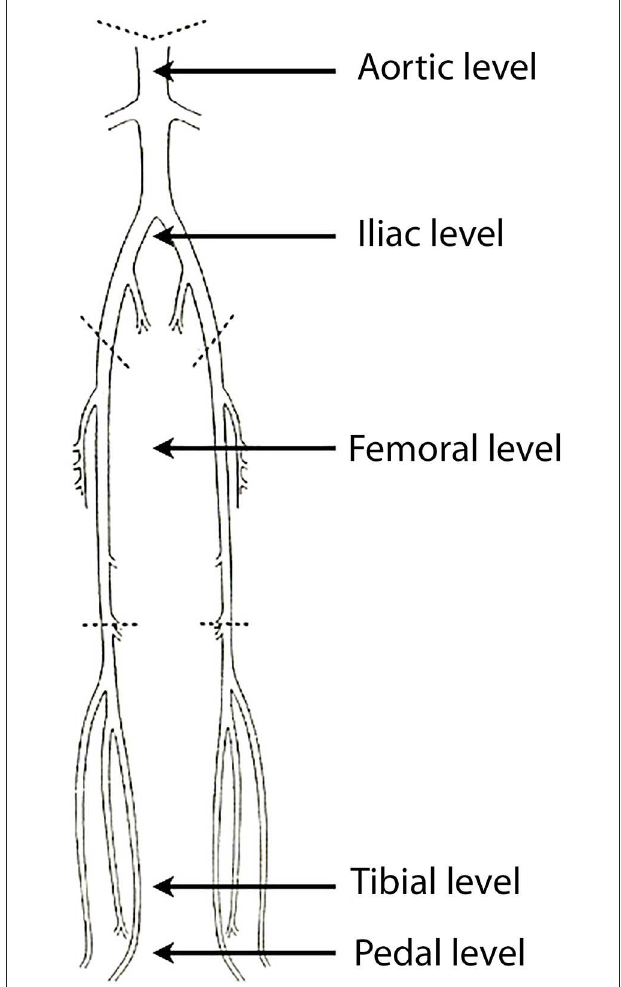
FIGURE 1 | Graphical representation of the arterial supply of the lower limbs. Intraluminal CT values were measured at five levels of interest (black arrows): aortic level, iliac level, femoral level, tibial level, pedal level.